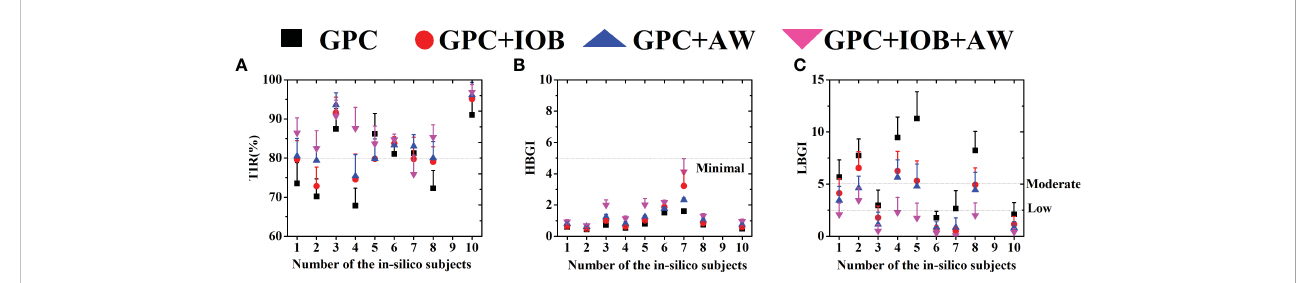
FIGURE 4 (A) The TIR of 9 in-silico subjects. (B) The HBGI of 9 in-silico subjects. (C) The LBGI of 9 in-silico subjects. Black squares represent the test with GPC controller, red circulars represent the test with GPC+IOB controller, blue triangles represent the test with GPC+AW controller and the pink triangles represent the test with GPC+IOB+AW